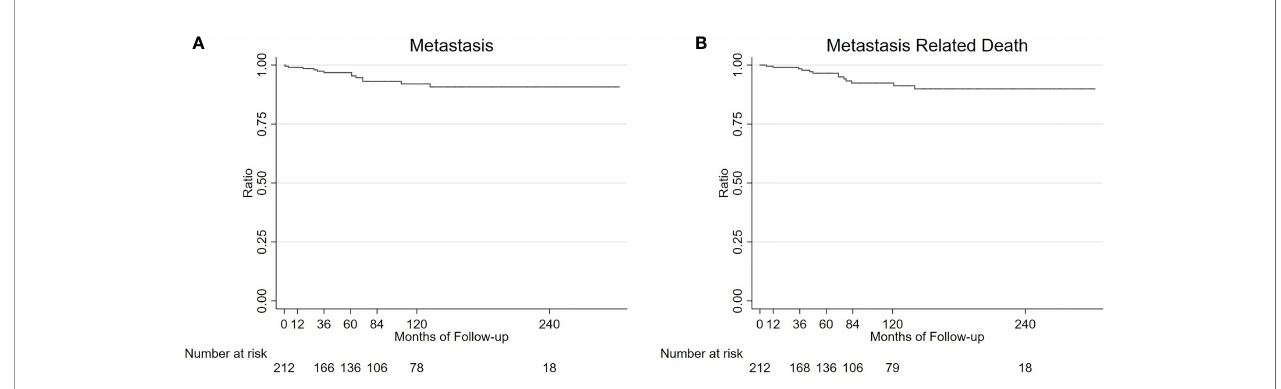
FIGURE 6 | Survival analysis of 213 UM patients. Kaplan-Meier estimated that the 1, 3, 5, 7, and 10-year metastasis rates and metastasis related death rate (95% CI) in 213 UM patients were 0.5% (0.1%-3.3%), 3.2% (1.4%-7.0%), 3.2% (1.4%-7.0%), 6.9% (3.8%-12.3%), and 6.9% (3.8%-12.3%) (A) ; and 1.0% (0.2%-3.4%), 1.6% (0.5%-4.8%), 3.5% (1.6%-7.6%), 7.6% (4.2%-13.5%), and 7.6% (4.2%-13.5%) (B)